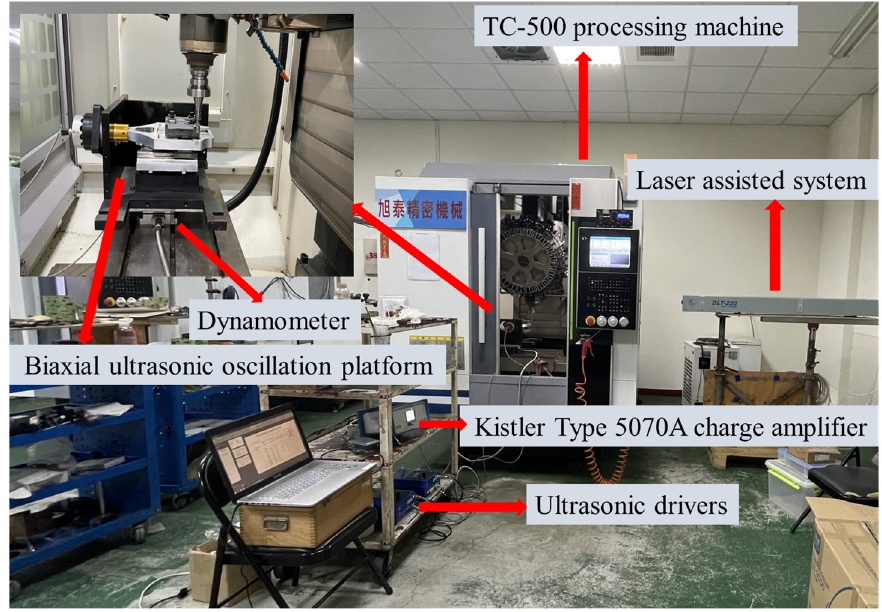
Figure 2. Description of the experimental setup.